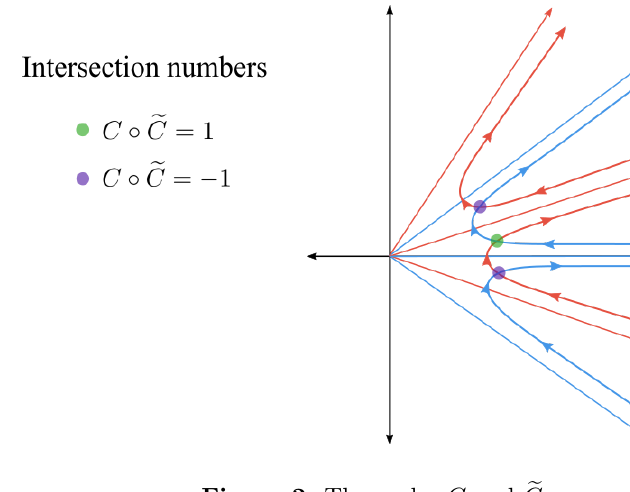
Figure 2 . The cycles C and e C